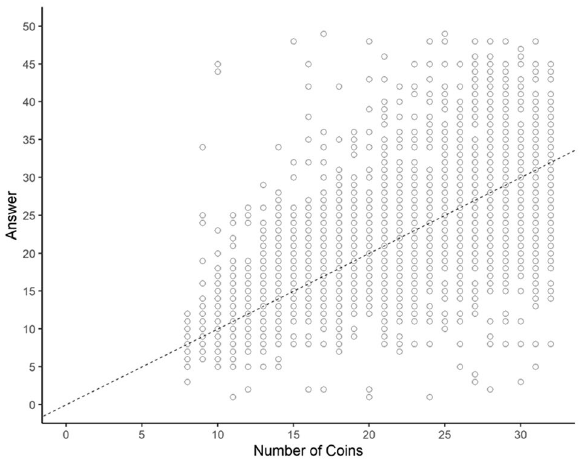
Figure 2. Performance on the coin count estimation task in Experiment 1 (scatter plot with the true number of coins on the x-axis and the estimated number of coins on the y-axis). The dotted line represents the case where the participant precisely estimated the true number of